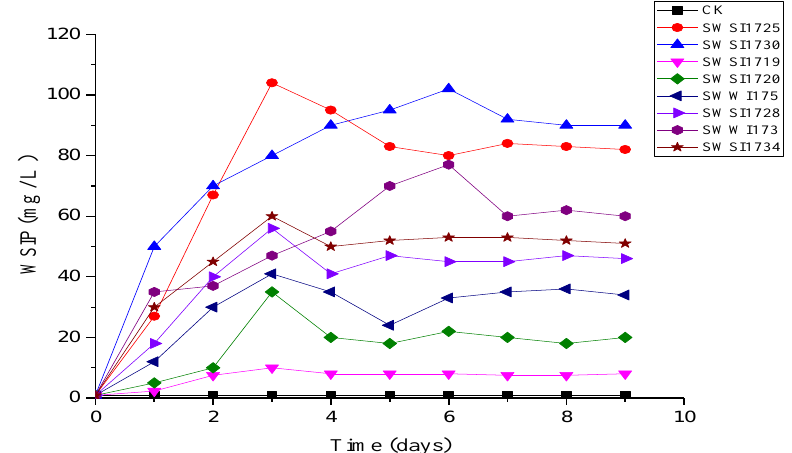
Figure 3. The Phosphate-solubilizing activities of 8 representative isolates cultured in PVK medium. Note: growing broth at 25 °C after 1, 2, 3, 4, 5, 6, 7, 8, and 9 days of growth. Each value is a mean of 3 independent replicates. CK: uninoculated control. The strains of SWSI1725, SWSI1730, SWSI1719, SWSI1720, SWWI175, SWWI173, SWSI1728, and SWSI1734 indicate the treatments inoculated, respectively.